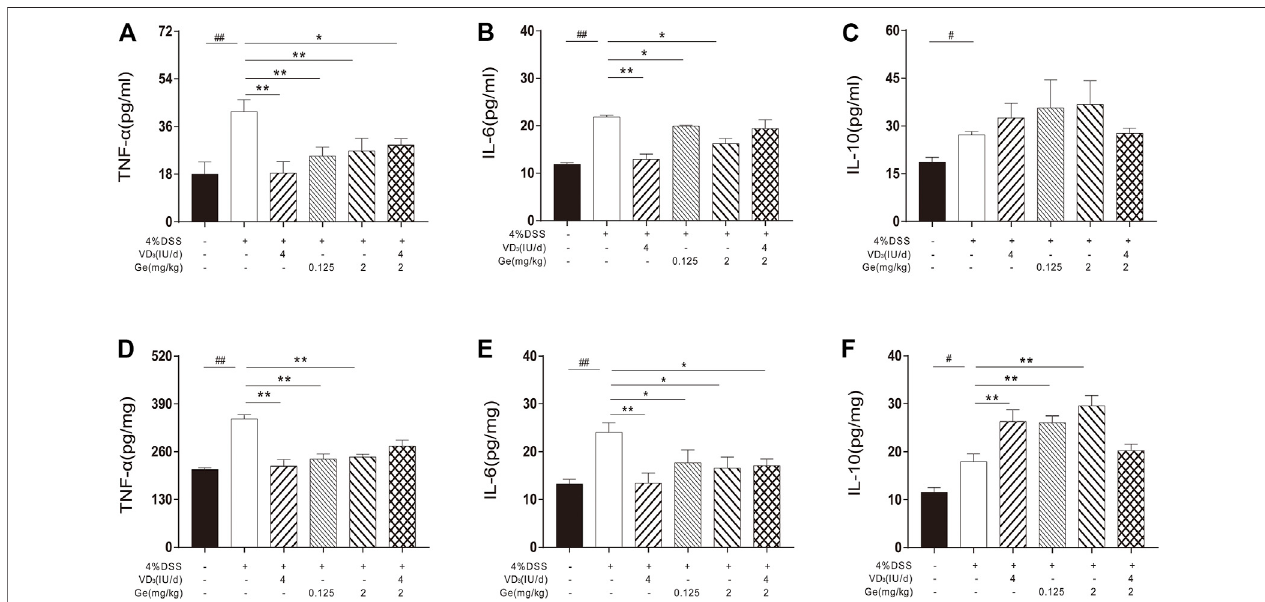
FIGURE 3 | Combined treatment of vitamin D 3 and geniposide exerted poor improvement on the levels of in fl ammatory cytokines. (A) Serum level of TNF- α . (B) SerumlevelofIL-6. (C) SerumlevelofIL-10. (D) TissuelevelofTNF- α . (E) TissuelevelofIL-6. (F) TissuelevelofIL-10. # p < 0.05, ## p < 0.01,vs.thenormalcontrolgroup; * p < 0.05, ** p < 0.01, vs. the model control group. n (cid:1) 8 per each group.